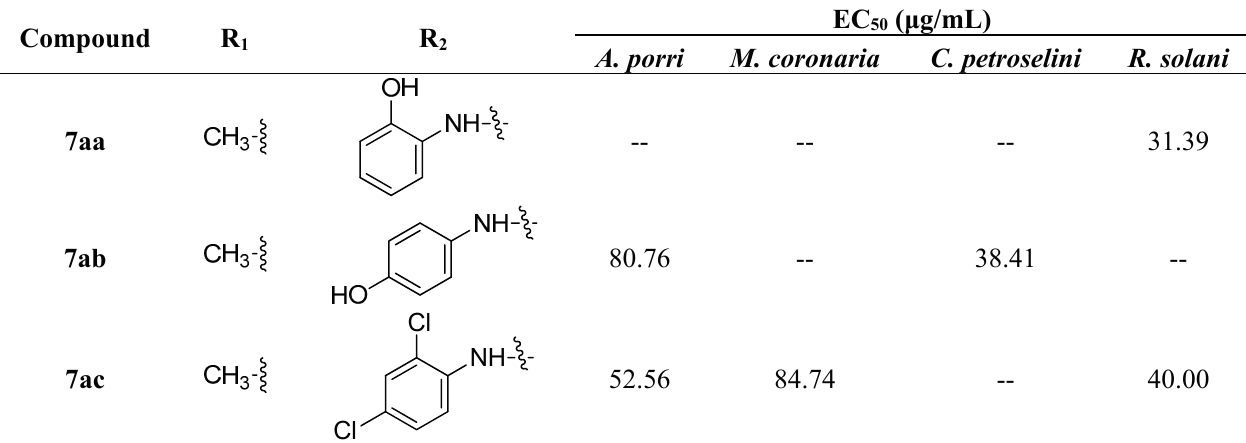
Table 1. EC 50 values of the pyrazole derivatives against four plant pathogenic fungi in vitro.